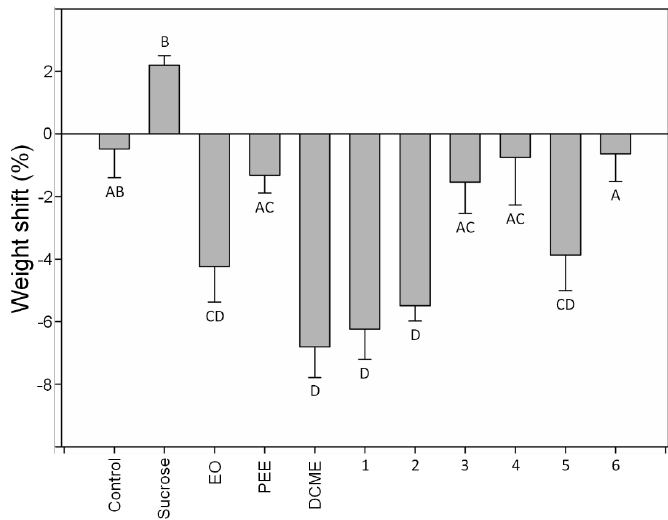
Figure 2. Weight shift (%) of H. obscurus adults fed with artificial diet supplemented with 10 µL of EO, PEE, DCME, and 1–6 sesquiterpenes that were diluted in CH 2 Cl 2 (1000 mg/L). Control: artificial